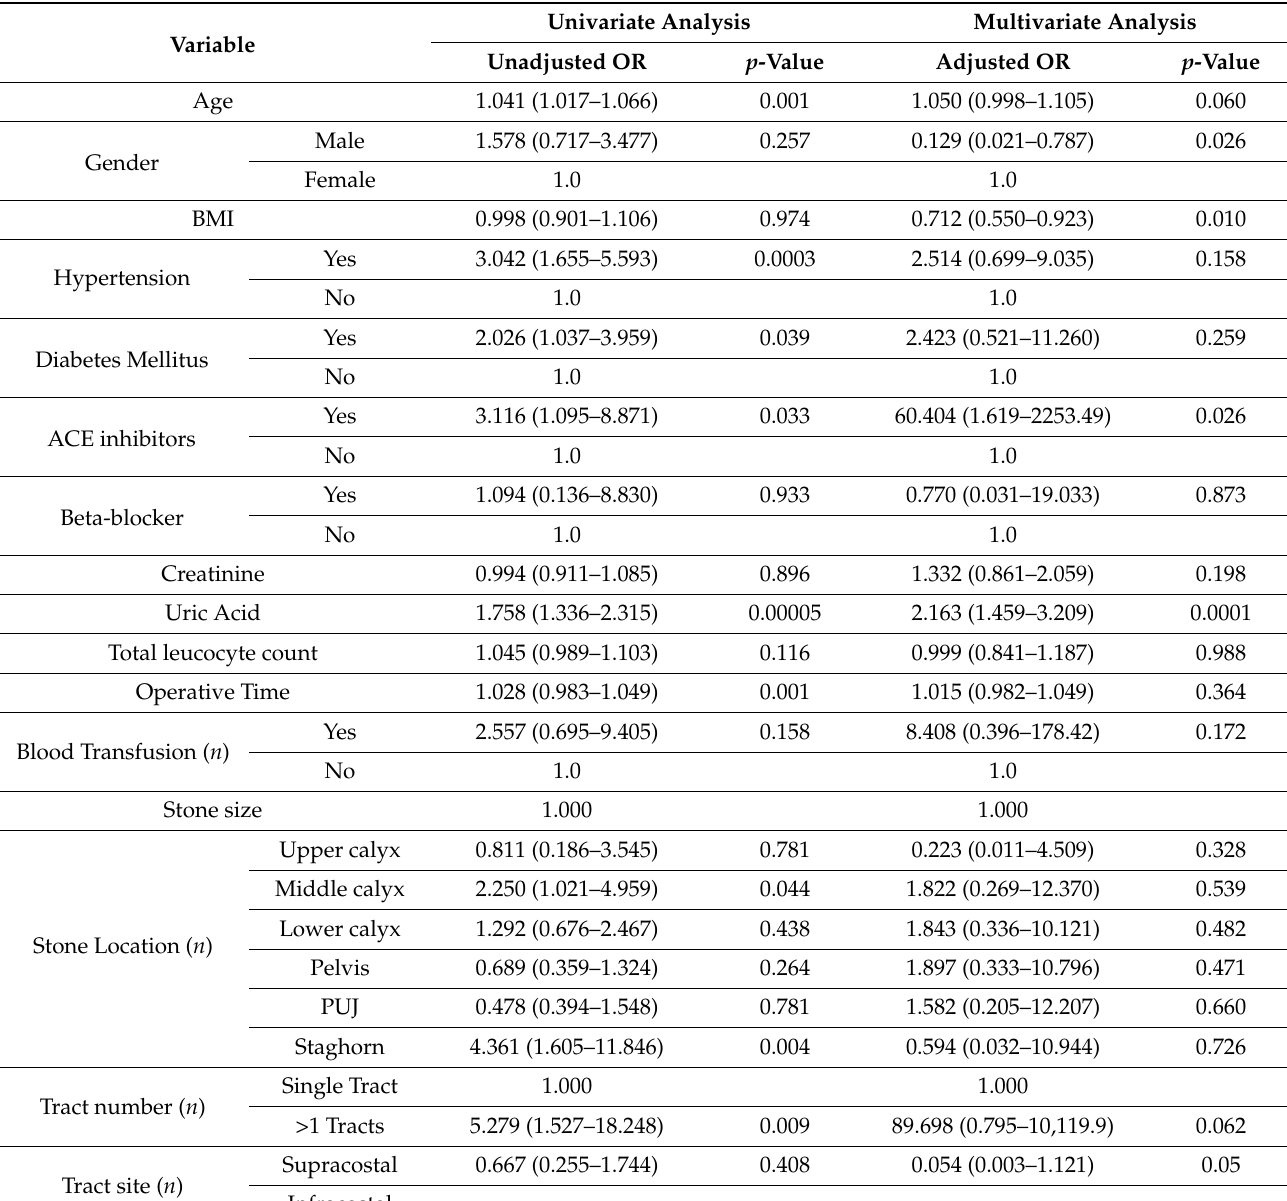
Table 4. Univariate and multivariate logistic regression analyses for predictors of post-PNL Acute Kidney Injury (AKI).